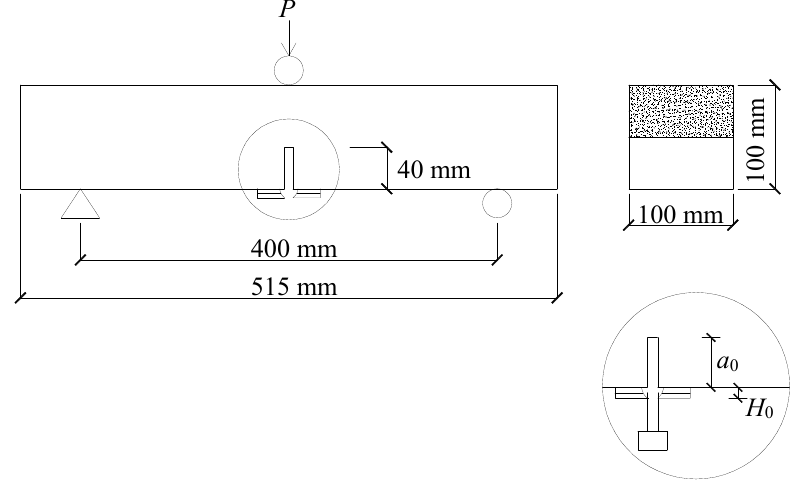
Figure 1. Configuration of the three-point bending (TPB) test beams [20].